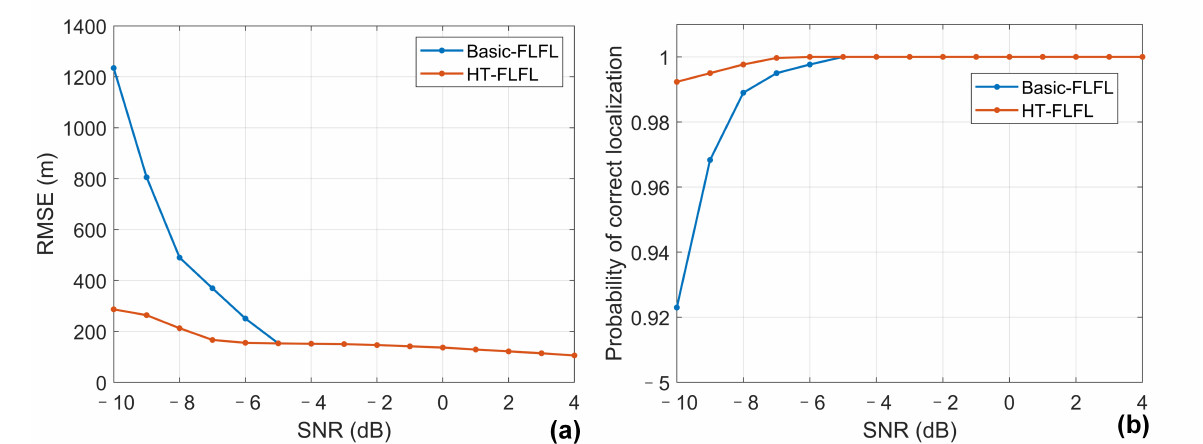
Figure 8. (Color online) ( a ) Localization performance and ( b ) probability of correct localization comparison of the Basic-FLFL method and the proposed HT-FLFL method.